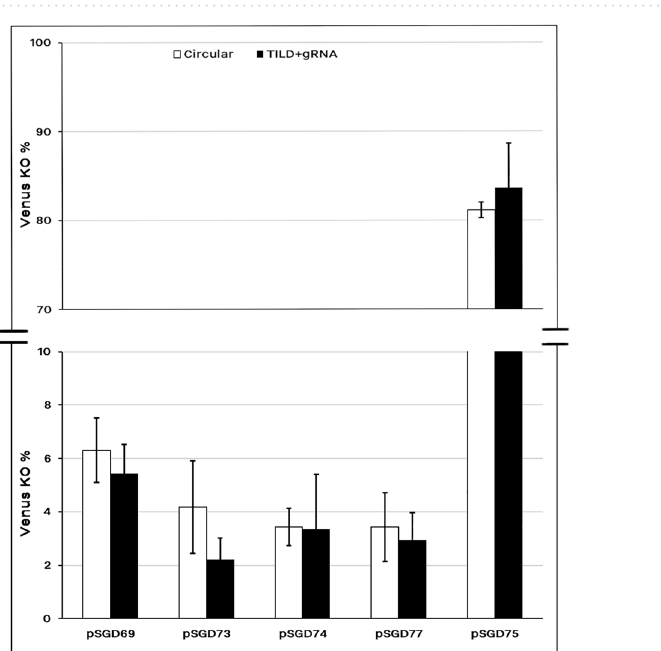
Figure 4. Evaluation of DNA quality on the cell survival rate following electroporation. ( A ) Twenty micrograms of SGD plasmids were used for electrotransfection either in 10 µl (2 µg/µl) or 20 µl (1 µg/µl) of the electroporation medium (250 µl). ( B ) The effect of ethanol washing of anion exchange column-prepared DNA was assessed on the cell survival rate using different large plasmids.